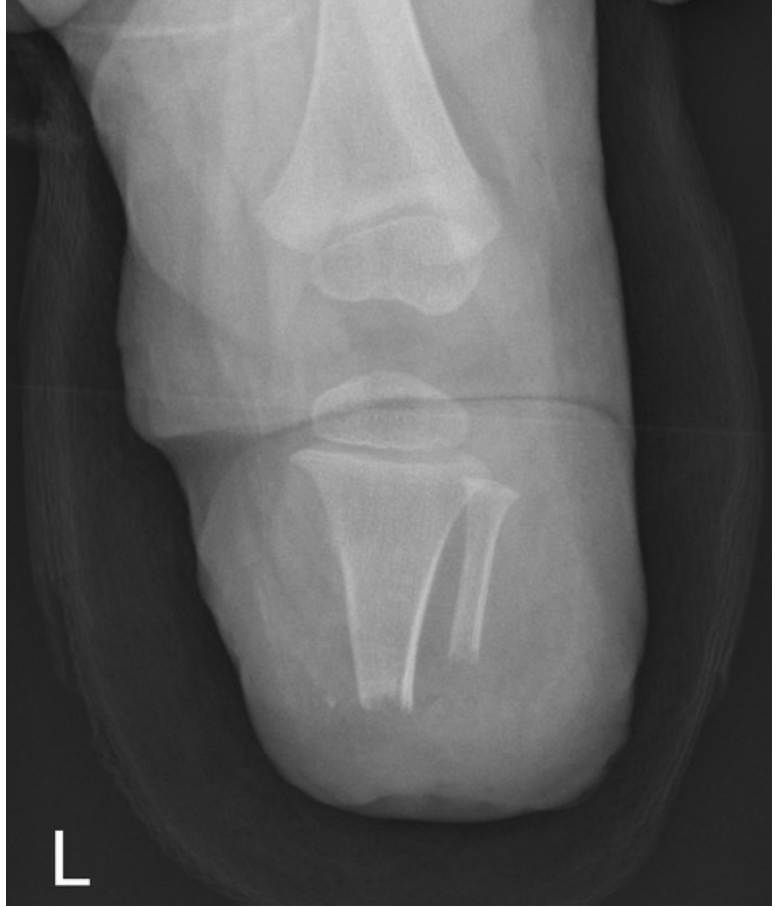
Figure 1. X-ray image of a patient included in our dataset. To create the dataset, all surgical procedures with a corresponding code were selected from the internal procedure list. Then, a review of the collected data using the